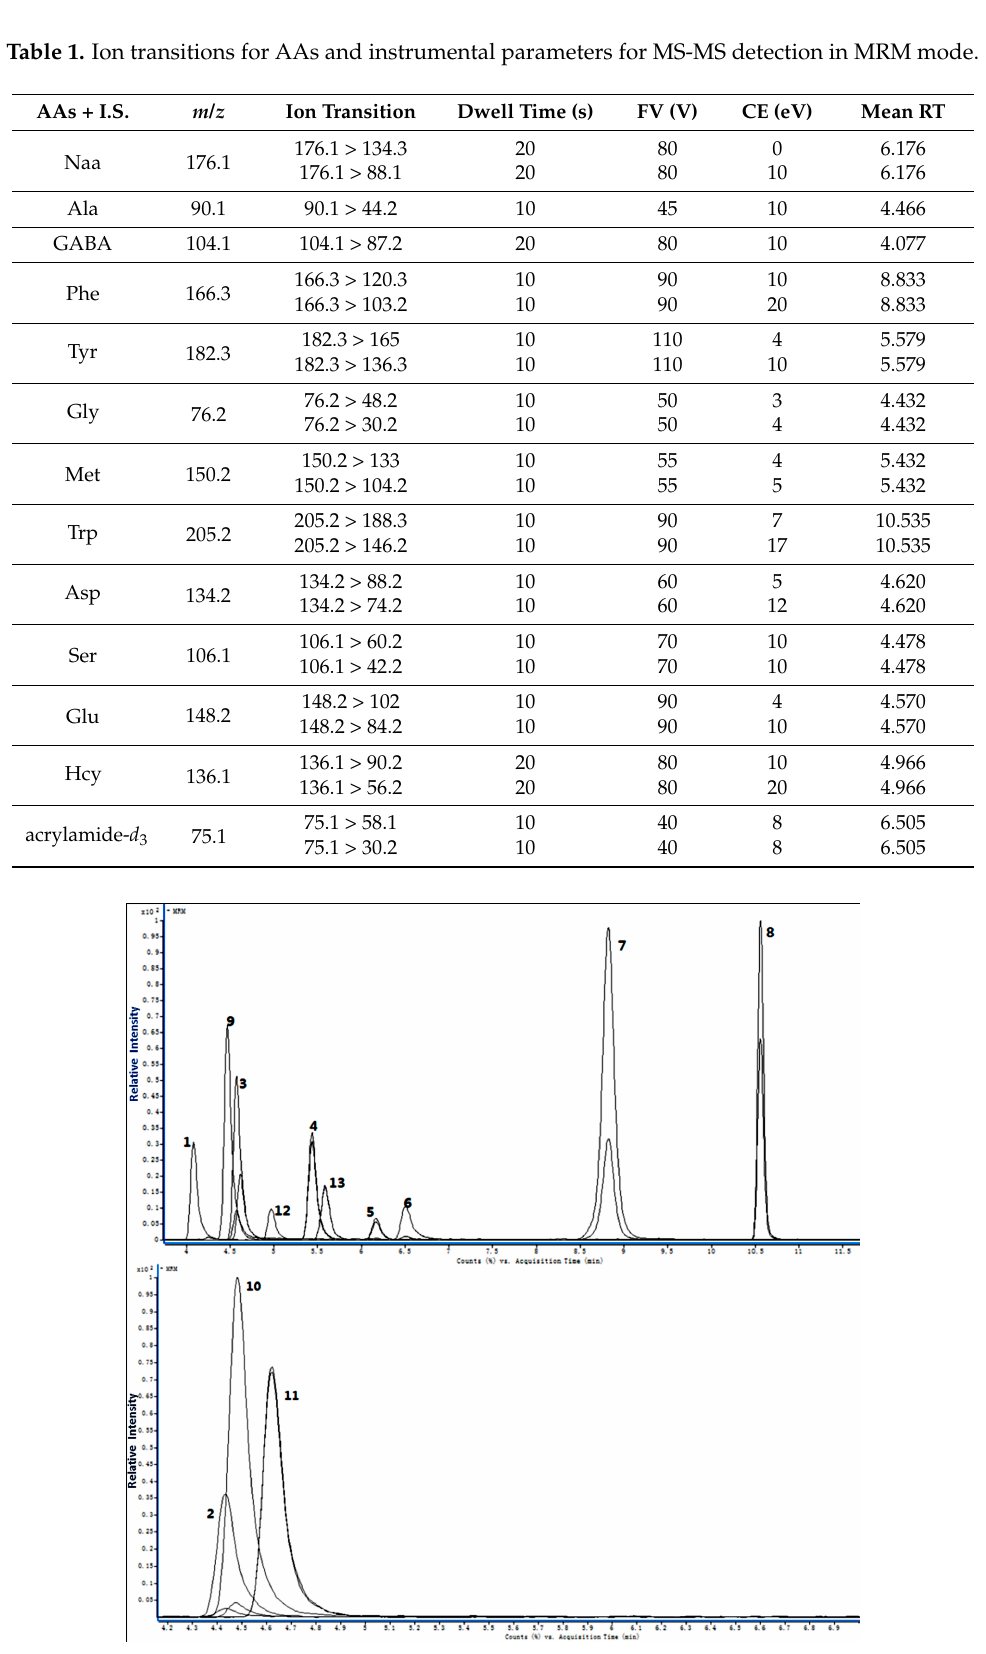
Figure 1. RRLC-MS/MS MRM chromatogram of the 12 AAs. 1, GABA; 2, Gly; 3, Glu; 4, Met; 5, Naa; 6, I.S.; 7, Phe; 8, Trp; 9, Ala; 10, Ser; 11, Asp; 12, Hcy; 13, Tyr.